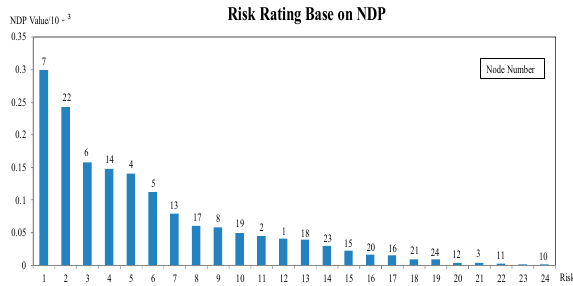
Figure 5. Diagram of risk rating based on the NDP in the RTS-79 system.